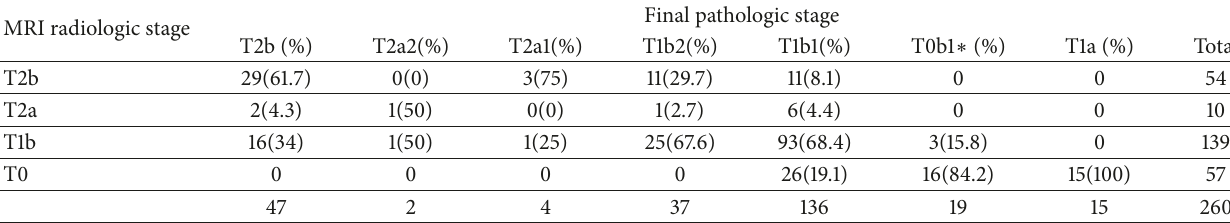
Table 4: Comparison between final pathologic stage and MRI radiologic stage.